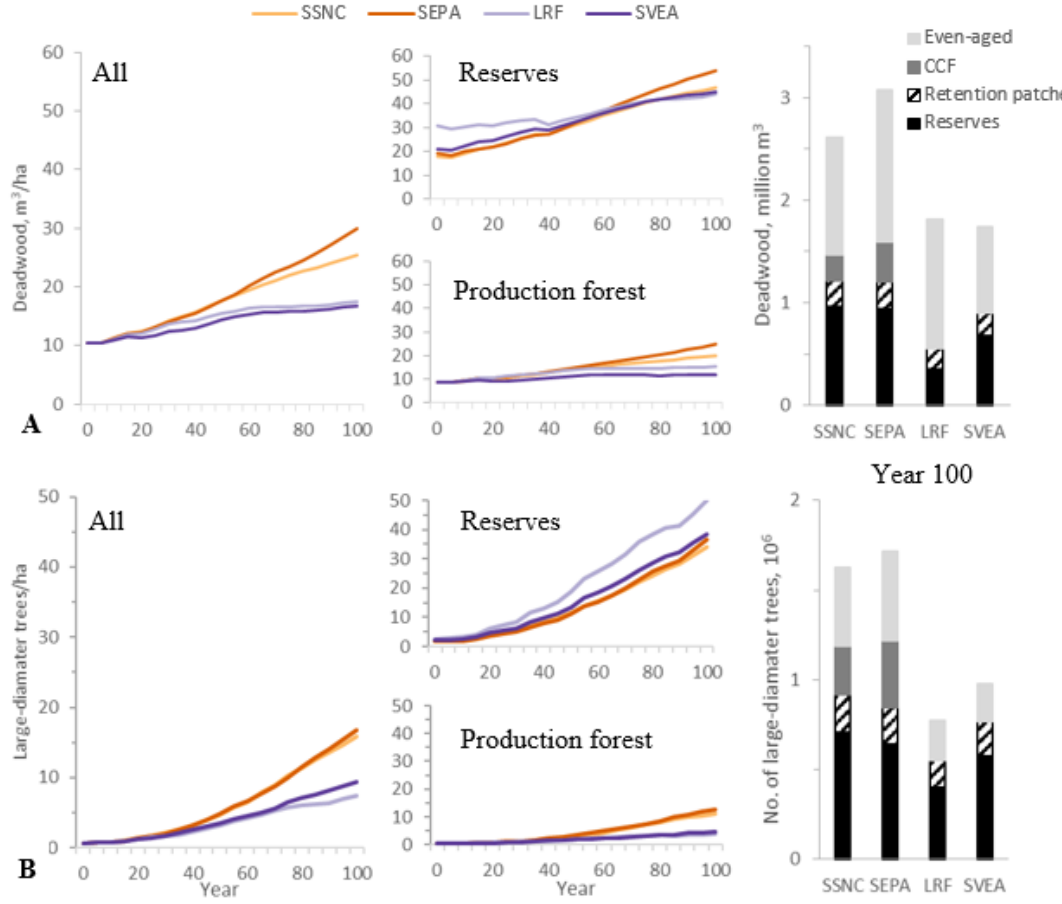
Figure 6. Deadwood volume ( A ) and number of large-diameter trees ( B ) in the four stakeholder scenarios; development over time in all forest (left), reserves and production forest (middle), and after 100 years under different management regimes (right).